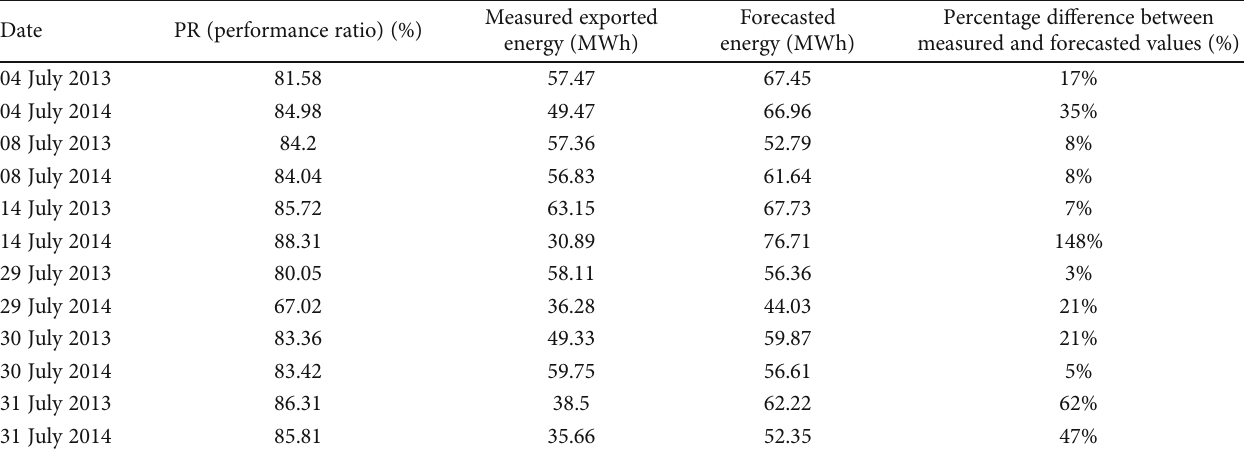
Table 11: PV park — comparison between measured and forecasted energy using PR of the PV system. Date PR (performance ratio)